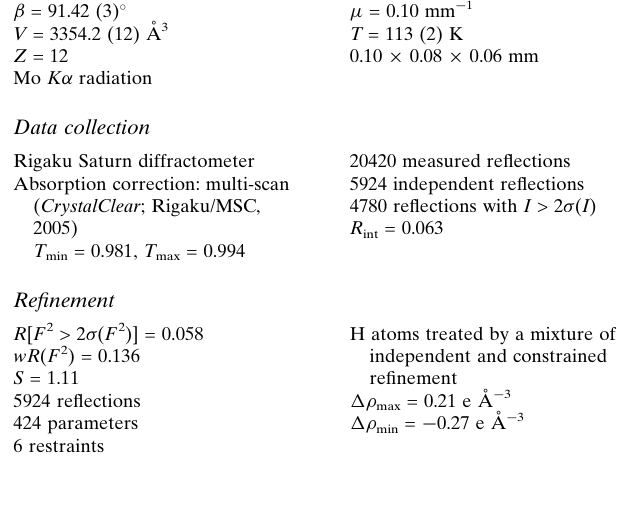
Hydrogen-bond geometry (A˚ , (cid:2)